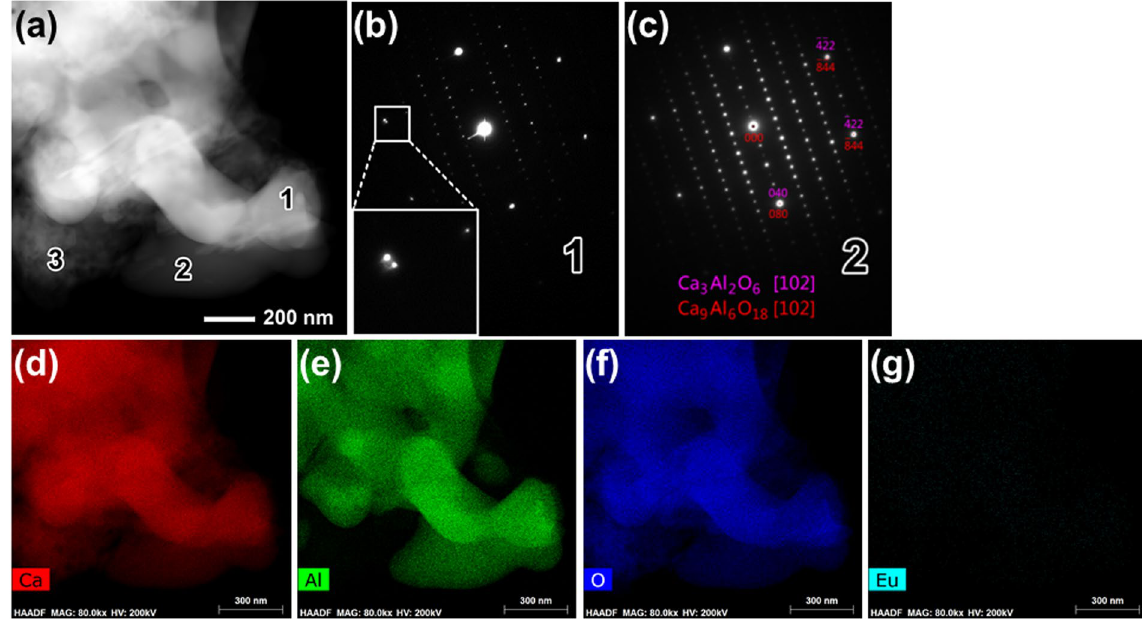
Figure 3. Detailed TEM analysis results of the as-prepared Eu-doped calcium aluminate sample. ( a ) HAADF image, ( b ) EDP from spot marked by “1” in ( a ), ( c ) EDP from spot “2”, ( d – g ) elementary maps of Ca, Al, O and Eu, respectively.